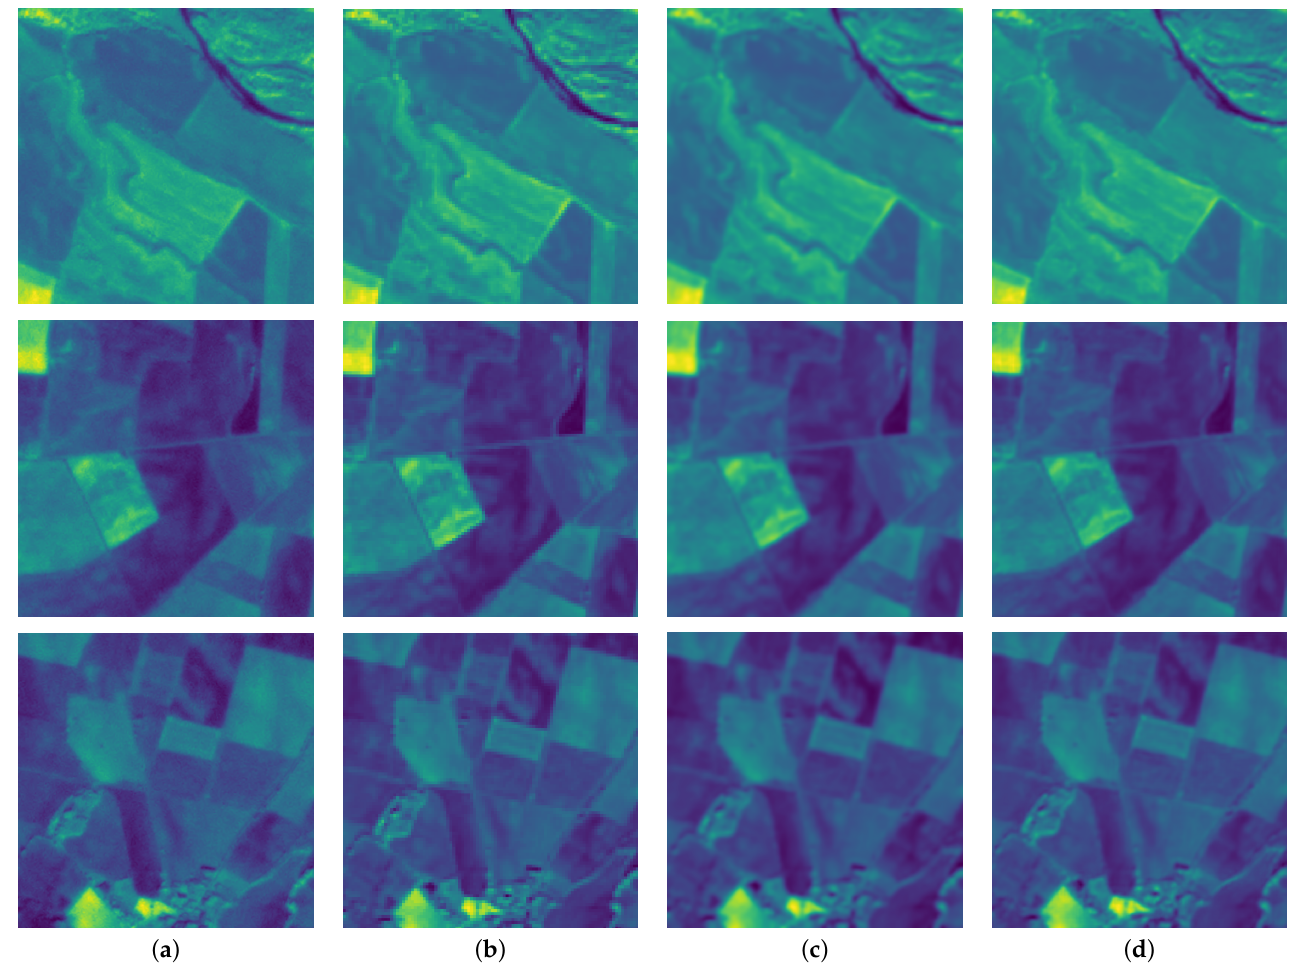
Figure A2. Visual comparison (NIR) between images from the test set. ( a ) HR; ( b ) LR with nearest neighbour interpolation; ( c ) LR with bicubic interpolation; ( d ) SARNet8. The results obtained with SARNet8 are sharper than those obtained with the other